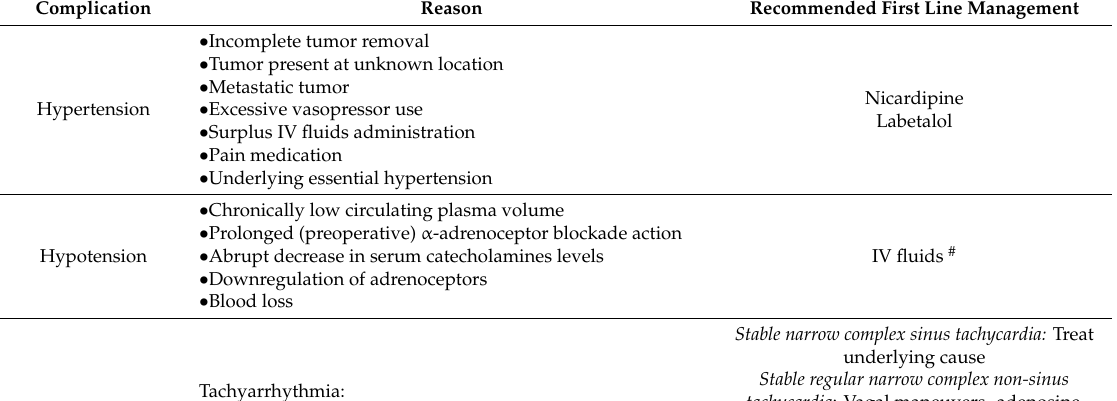
Table 5. Postoperative complications following PPGL